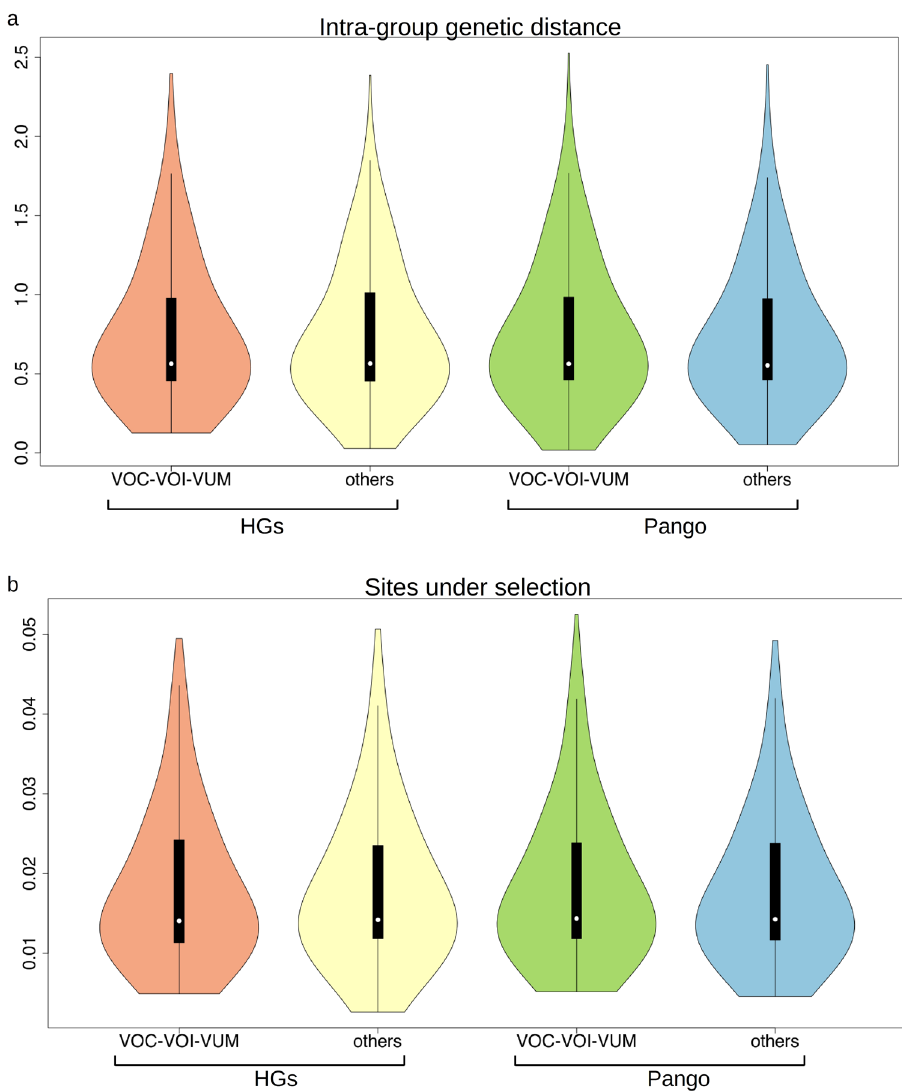
Fig. 5 Distribution of the intra-group genetic distance and sites under selection in VOCs/VOIs/VUMs compared to other variants. a Distribution of genetic distance, computed as the total number of distinct polymorphic sites between closest pairs of genomes assigned to Pango/Pango + lineages and HGs, separately for VOC/VOI/VUM and for non VOC/VOI/VUM variants (indicated as others). Distances are indicated on the Y -axis. b Proportion of non-de fi ning genomic variants predicted to be under selection (according to Hyphy) in Pango/Pango + lineages and HGs separately for VOCs/VOIs/ VUMs and for all remaining variants (indicated as others). Ratios are indicated on the Y -axis. Distributions are represented in the form of a violin plot. In the boxplots, white dots denote median values; boxes extend from the 25th to the 75th percentile; vertical extending lines denote adjacent values (i.e., the most extreme values within 1.5 interquartile range of the 25th and 75th percentile of each group). The source data behind this fi gure is reported in Supplementary Data